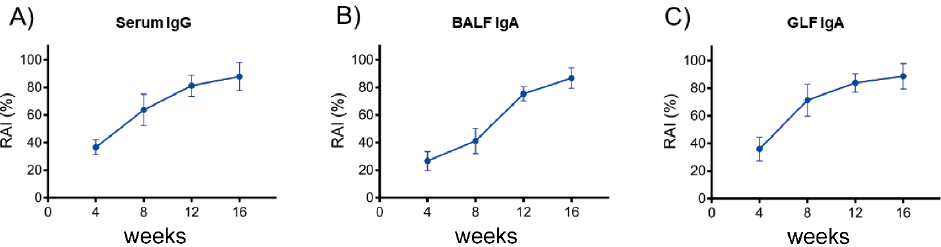
Figure 6. Specific anti-SARS-CoV-2 spike IgG antibody avidity detected in sera samples of EcN- pAISA1-SP immunized group at weeks 4, 8, 12, and 16 ( A ). Specific anti-SARS-CoV-2 spike IgA antibody avidity detected in BALFs samples of EcN-pAIDA1-SP immunized group at weeks 4, 8, 12, and 16 ( B ). Specific anti-SARS-CoV-2 spike IgA antibody avidity detected in GLFs samples of EcN-pAISA1-SP immunized group at weeks 4, 8, 12, and 16 ( C ). Results were calculated as ODurea/ODreference and express as a percentage of n = 4 experiments performed in triplicate.